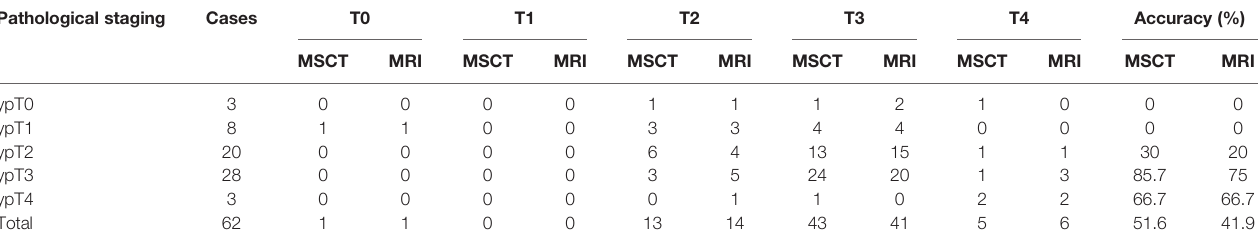
TABLE 3 | Diagnostic results of MSCT, MRI, and pathological examination for T restaging of rectal cancer after NCRT. Pathological staging